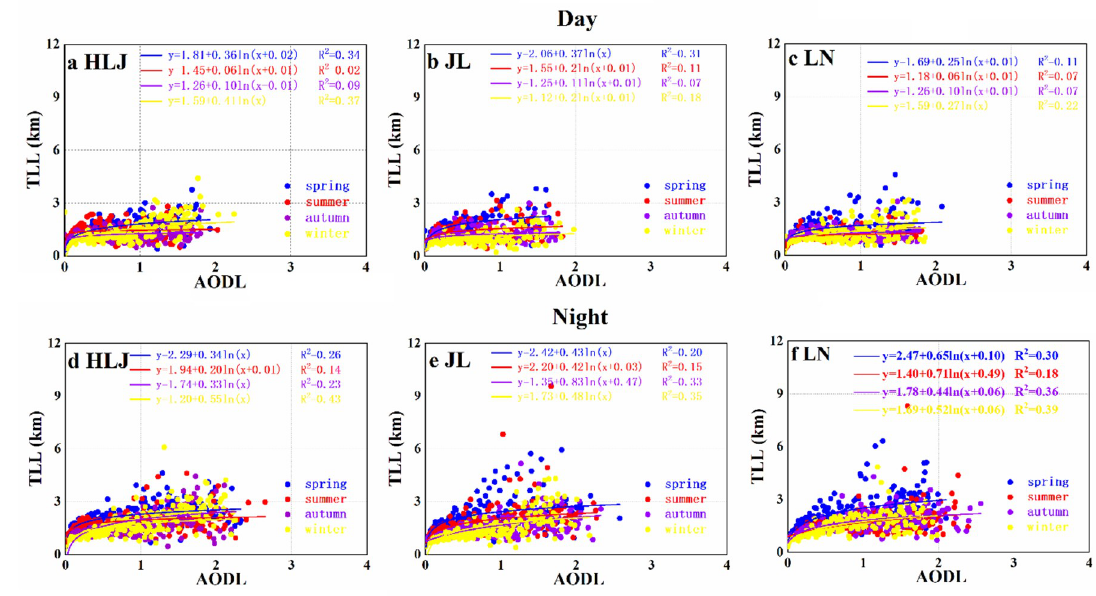
Figure 10. The correlation between AODL and TLL over NEC. Where, ( a , d ) represent HLJ, ( b , e ) represent JL, and ( c , f ) represent LN. represent JL, and ( c , f ) represent LN. Atmosphere 2020 , 11 , x FOR PEER REVIEW